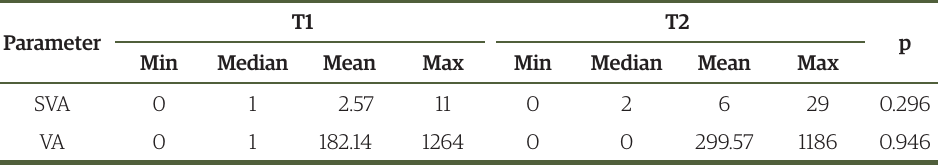
Table 3. Arrhythmias observed during long-term electrocardiography in dogs (n=8) with stage C mitral valve disease before (T1) and 30 days after (T2) initiation of therapy with